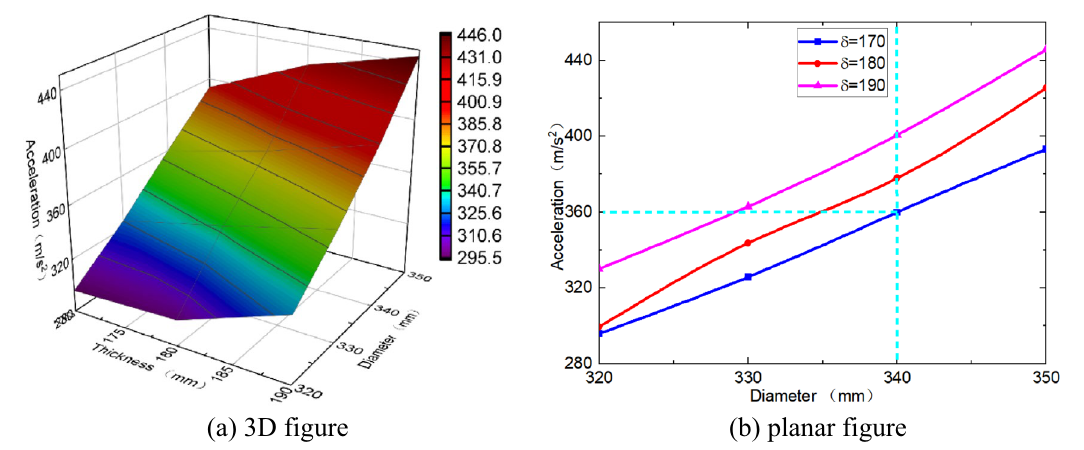
Fig. 13 Acceleration at different diameter and thickness of eccentric